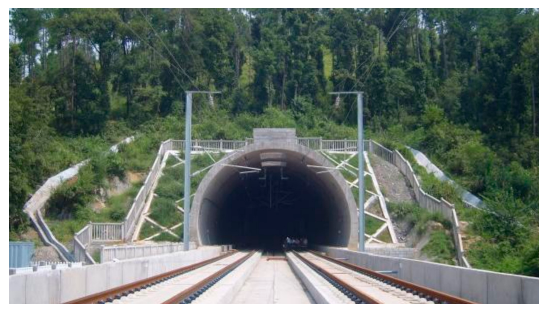
Figure 9. The Pingtu tunnel used for real train experiment. Figure 8. The Pingtu tunnel used for real train experiment.